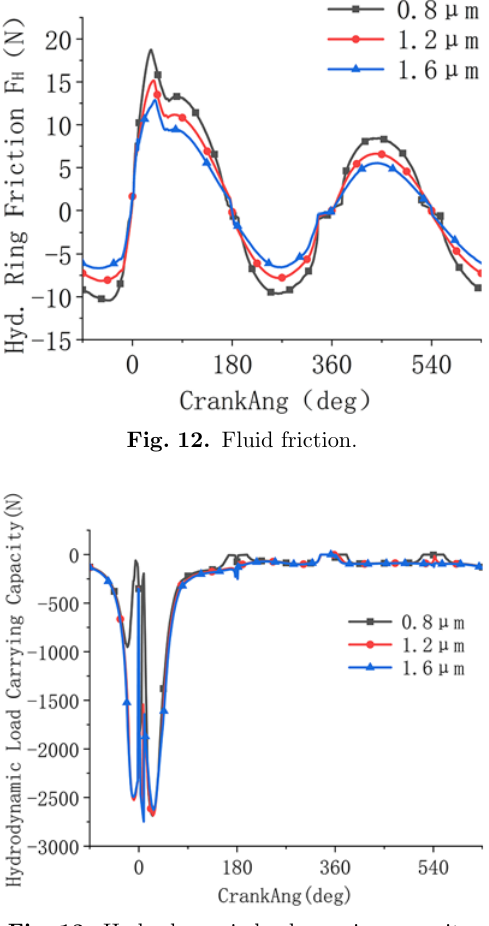
Fig. 13. Hydrodynamic load carrying capacity.